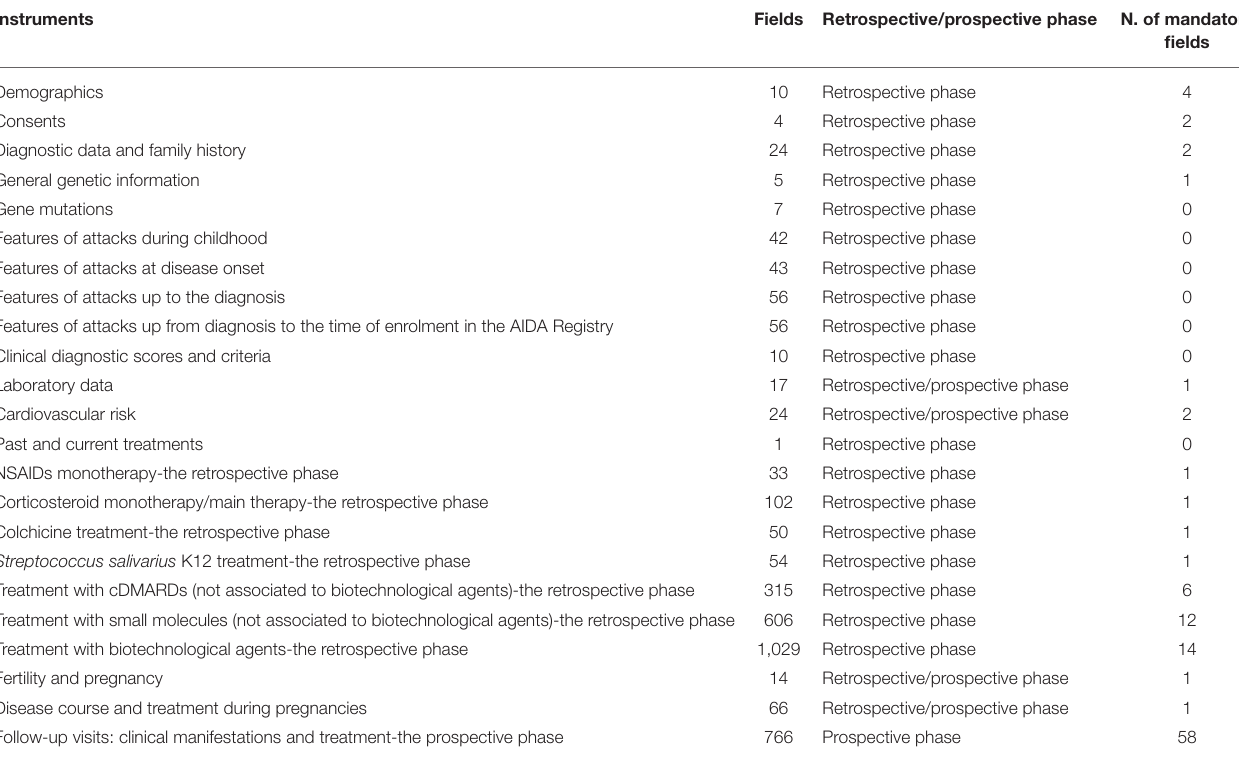
TABLE 2 | List of instruments (forms) included in the AIDA International Registry dedicated to USAIDs patients, with the corresponding number of common data elements, time-points at which they should refer to and number of mandatory fields included.